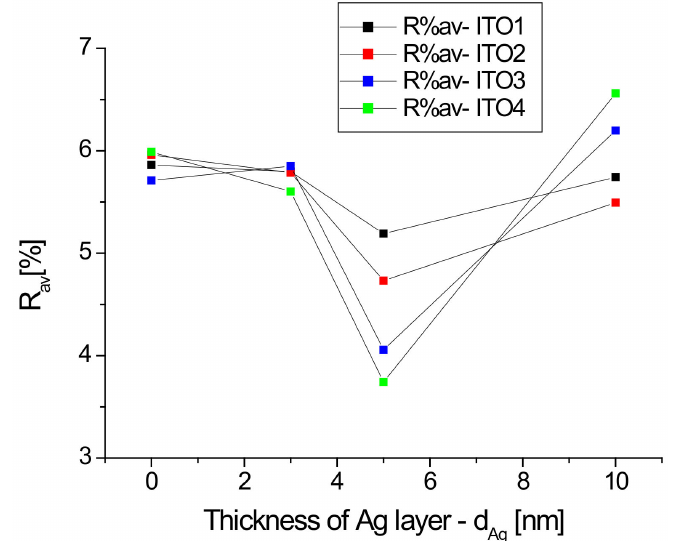
Figure 4. Dependencies of average reflectance in the visible region as a function thickness of Ag nanoparticle